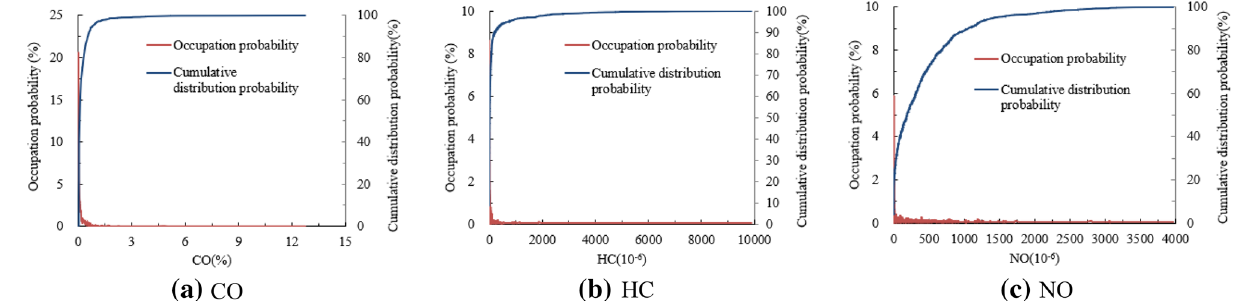
Figure 3. Probability distribution and cumulative distribution probability of RS data of CO, HC and NO emissions from light-duty gasoline vehicles tested under ASM5024.